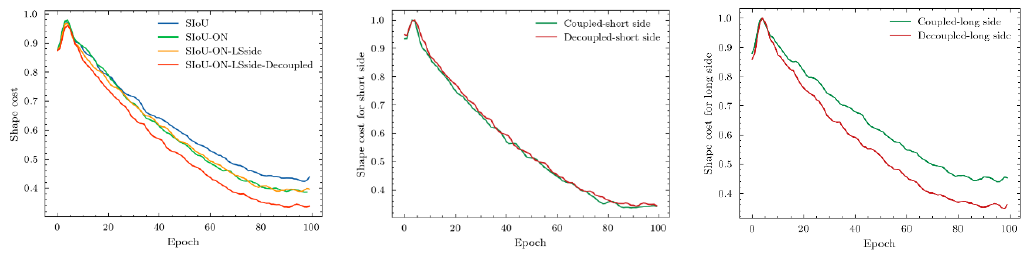
Figure 10. Ablation experiments on loss reduction curves for SD-SIoU.